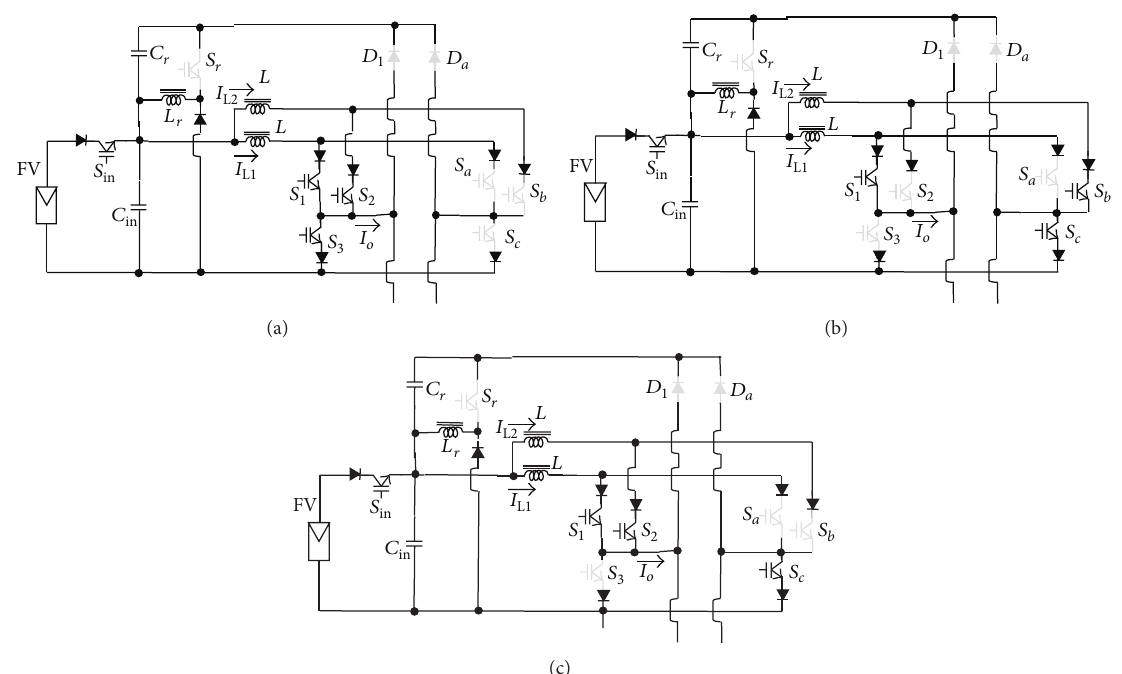
Figure 5: Subcircuits of the proposed multilevel CSI. (a) Subcircuit for zero current. (b) Subcircuit for positive current. (c) Subcircuit for double positive current.